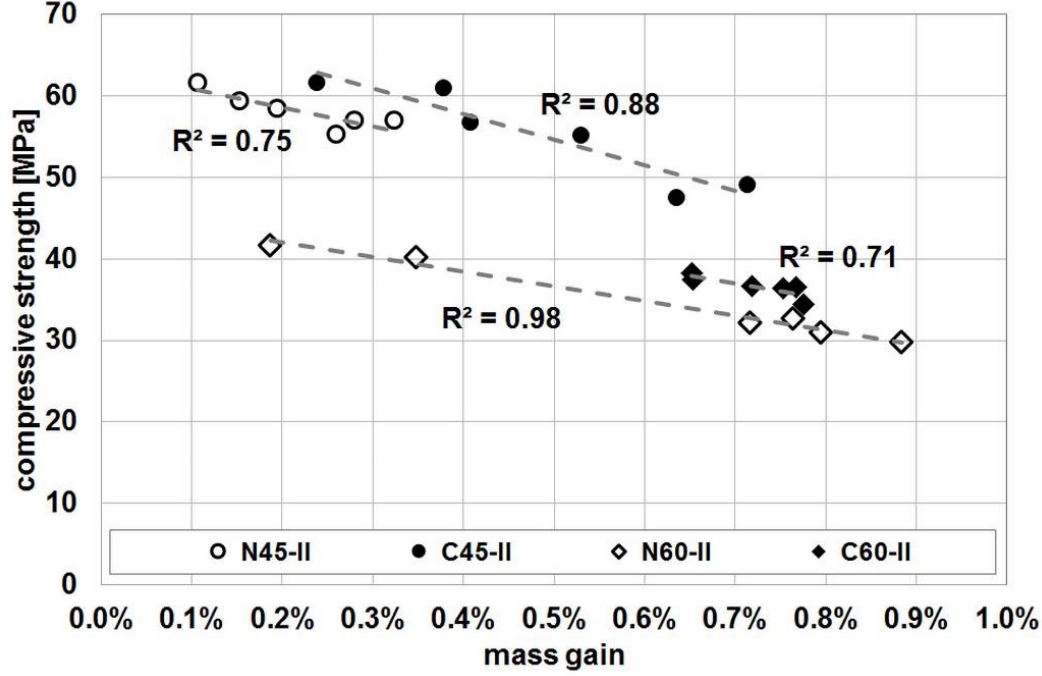
Figure 4. Correlation between specimen weight gain and compressive strength after 100 freeze/thaw cycles.